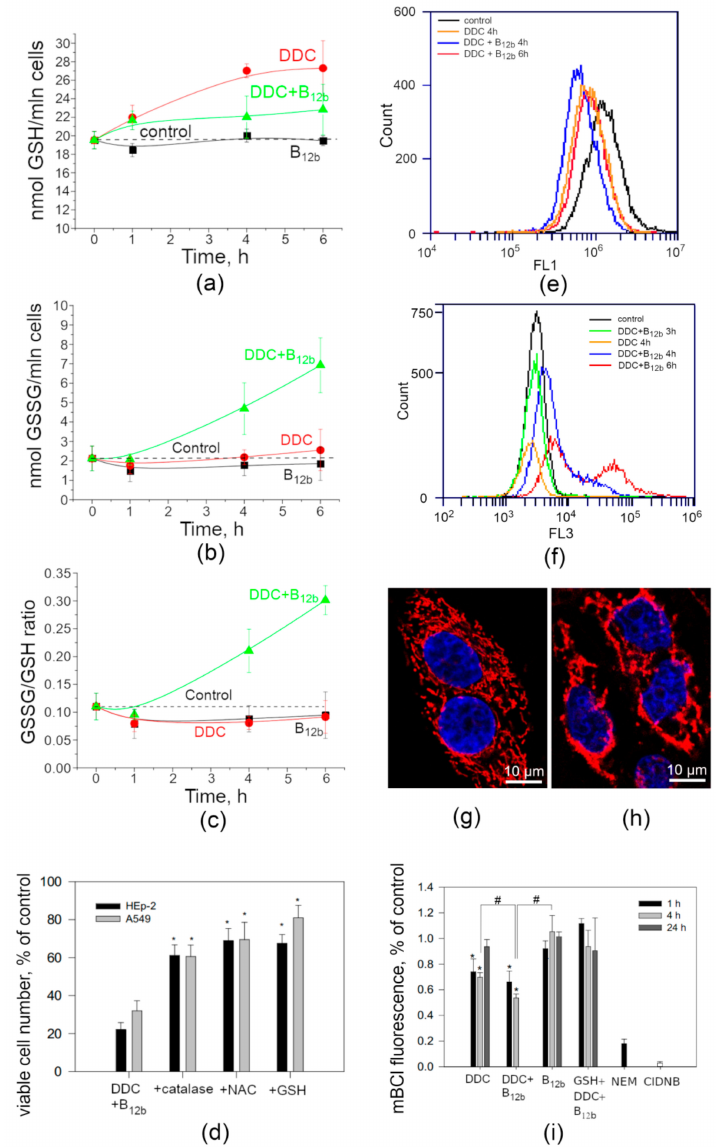
Figure 9. E ff ect of 1 mM DDC, 25 µ M B 12b , and of their combination on the cell redox balance. ( a – c ) Changes in the level of intracellular oxidized and reduced glutathione. At the indicated time, attached and detached HEp-2 cells were harvested and used for the determination of the content of GSH ( a ) and GSSG ( b ), and their ratio ( c ). Each measurement was repeated twice. ( d ) Antioxidants (catalase and thiols) partially inhibit the cytotoxic e ff ect induced by 6-h incubation with DDC + B 12b . * p < 0.05, compared to cells treated with DDC + B 12b . ( e ), ( f ) Flow cytometry data on oxidative activity in cells loaded with 20 µ M DCHFDA ( e ) and 1 µ M MitoSOX ( f ). ( g ) and ( h ) Confocal microscopy images of HEp-2 cells stained with H342 and MitoSOX before incubation ( g ) and after 4-h incubation ( h ) with DDC + B 12b . ( i ) Analysis of mBCl fluorescence in cells incubated with DDC and DDC + B 12b . After incubation, cells were washed twice and stained with 60 µ M mBCl. Cells incubated with 5 mM ClDNB (10 min) served as a negative control. *, di ff erences between samples and the control are significant, p < 0.05; #, di ff erences between samples are significant, p <